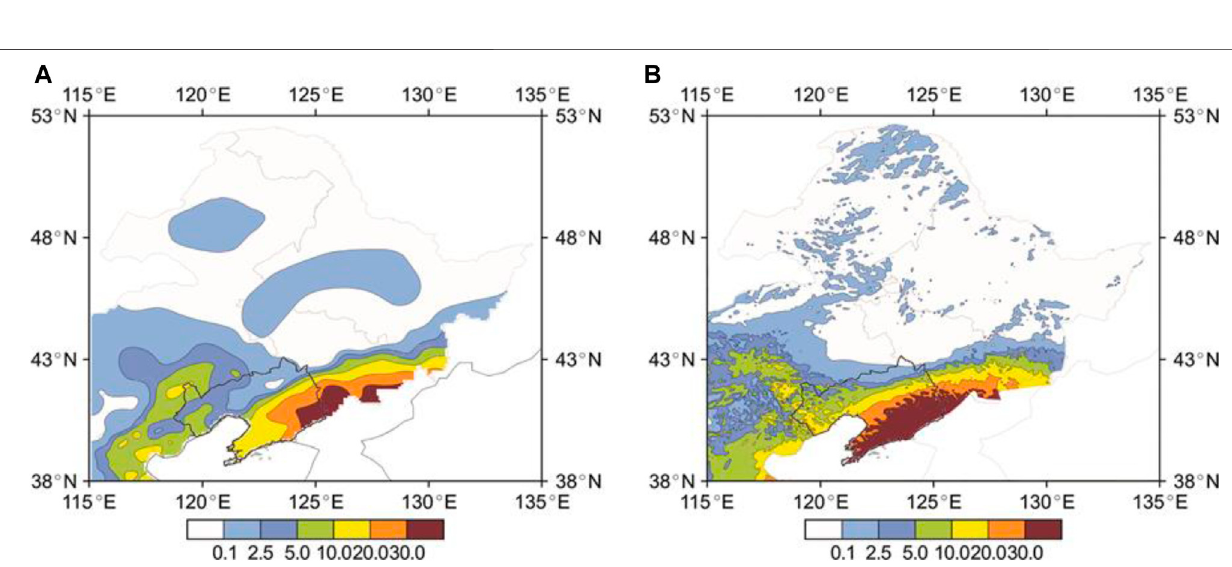
Frontiers in Earth Science |